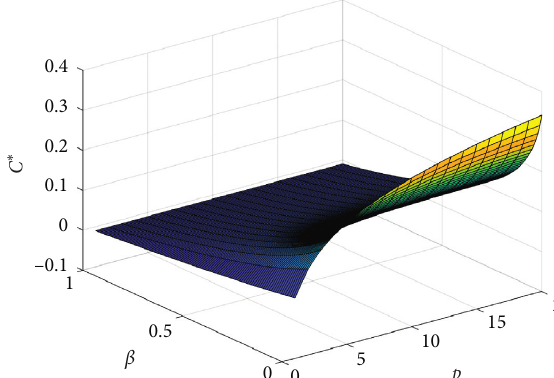
Figure 12: Effect of unit inventory cost h supply chain.